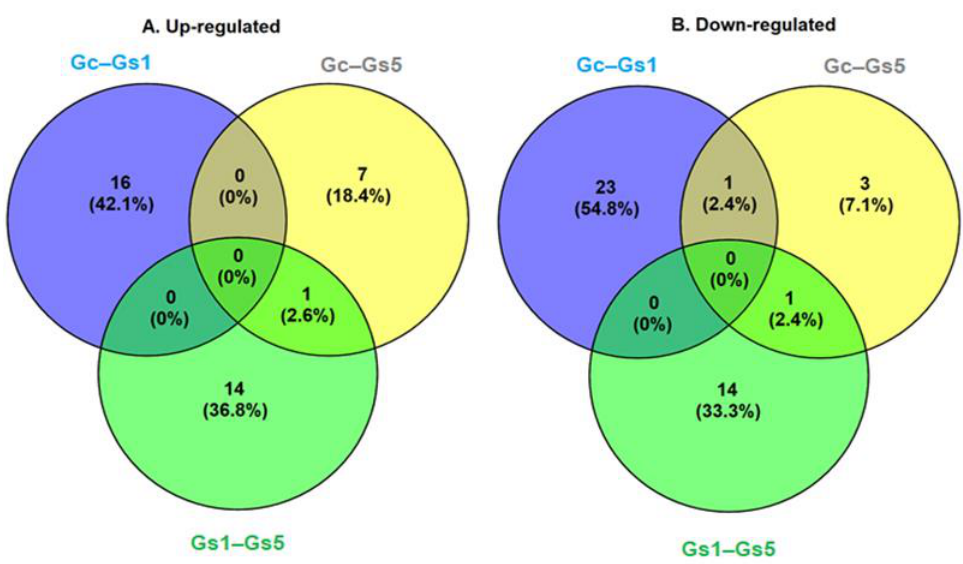
Figure 5. Venn diagrams indicating the number of genes differentially expressed in the transcriptome of the loggerhead turtle, Caretta caretta . ( A ) Upregulated genes and ( B ) downregulated genes in erythrocytes exposed in vitro to doses of 0, (Gc), 1 (Gs1), and 5 (Gs5) mg L − 1 of MeHg for 12 h.